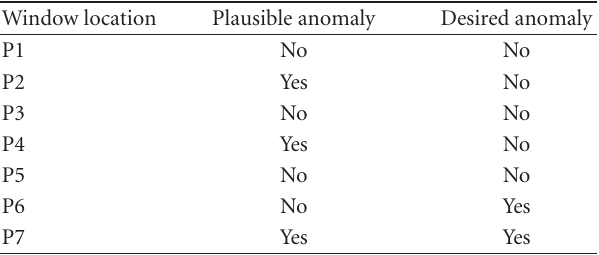
Table 2: Plausible versus desired declarations of global anomalies (Using R1, R2, and R3 as reference samples, see Figure